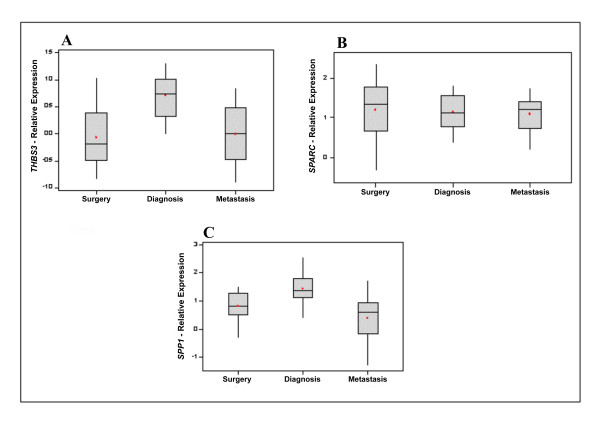
Relationship between gene expression and clinical evolution of disease. The box plot shows the median, upper and lower quartiles and minimum and maximum values for related gene expression. A- Relative expression of THBS3 in groups of OS patients represented by samples obtained from the biopsy diagnosis (n = 16), primary tumor surgery (n = 19) and metastases (n = 17) ; B- Relative expression of SPARC in groups of OS patients represented by samples obtained from the biopsy diagnosis (n = 26), primary tumor surgery (n = 16) and metastases (n = 13); C- Relative expression of SPP1 in groups of OS patients represented by samples obtained from the biopsy diagnosis (n = 16), primary tumor surgery (n = 20) and metastases (n = 17).